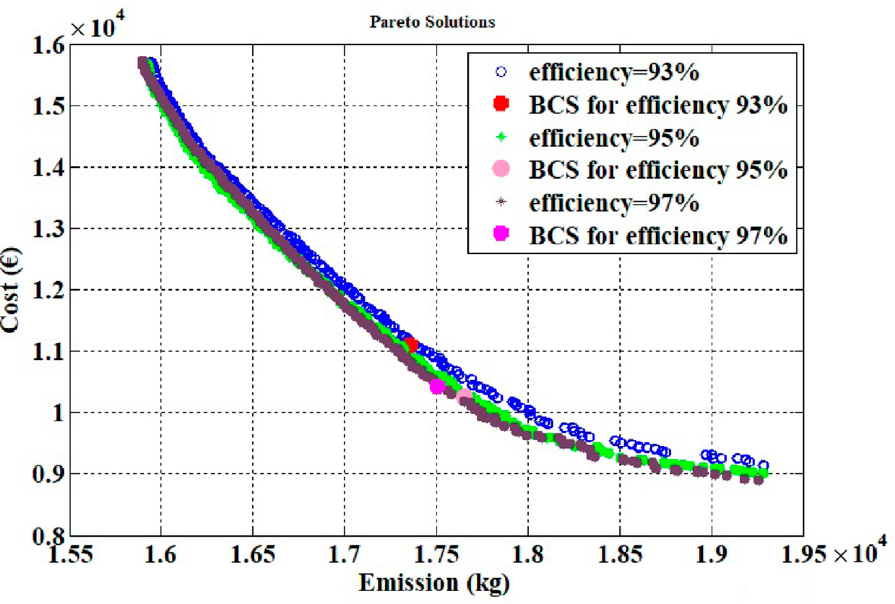
Figure 10. Pareto optimal front for different efficiencies along with their BCS points ( E = 100%). Scenario II: In the second scenario, in order to obtain the best value of the battery initial and final charges (initial charge = final charge = E), they are considered as decision variables. Figures 11–13 show comparisons of the Pareto optimal fronts for different E values in different efficiencies (i.e., 93%, 95% and 97%). It can be observed from Figures